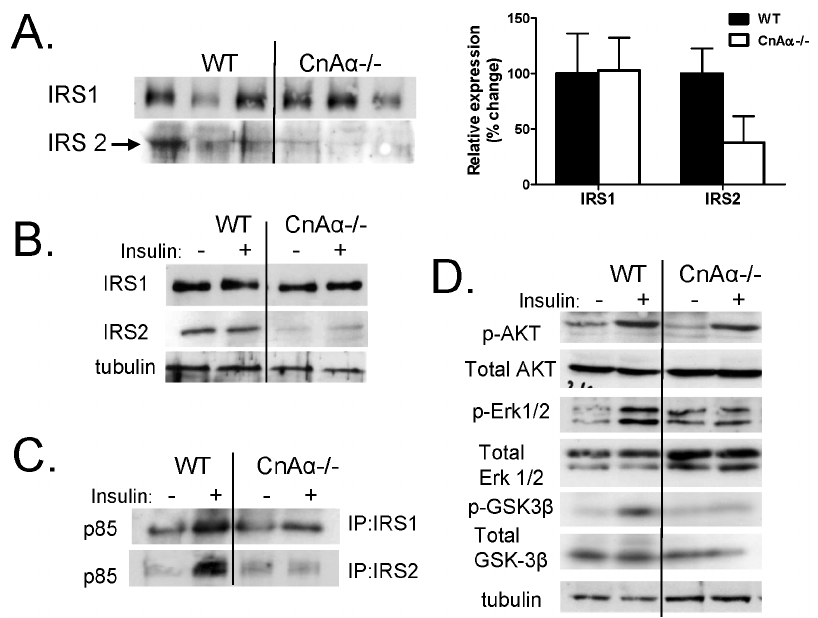
Figure 6. IRS2 expression and signaling is decreased in CnA a 2 / 2 muscle cells. A) Expression of IRS1 and IRS2 was determined in WT and CnA a 2 / 2 muscle lysates by western blotting. Each lane is tissue from a different animal. Data were semi-quantitated and graphed. B) IRS1 and IRS2 expression in cultured primary WT and CnA a 2 / 2 muscle cells with and without insulin treatment was determined by western blotting. Data shown are representative of at least 3 independent experiments. C) The association of IRS1 and IRS2 with the p85 catalytic subunit of PI-3kinase in response to insulin was determined by immunoprecipitation with anti-p85 antibody and then western blotting with anti-IRS1 or anti-IRS2 antibodies. Data shown are representative of at least 3 independent experiments. D) Activation of downstream signaling targets in response to insulin were compared in WT and CnA a 2 / 2 muscle cells by western blotting with total and phospho-specific antibodies as indicated. Data shown are representative of at least 3 independent experiments.